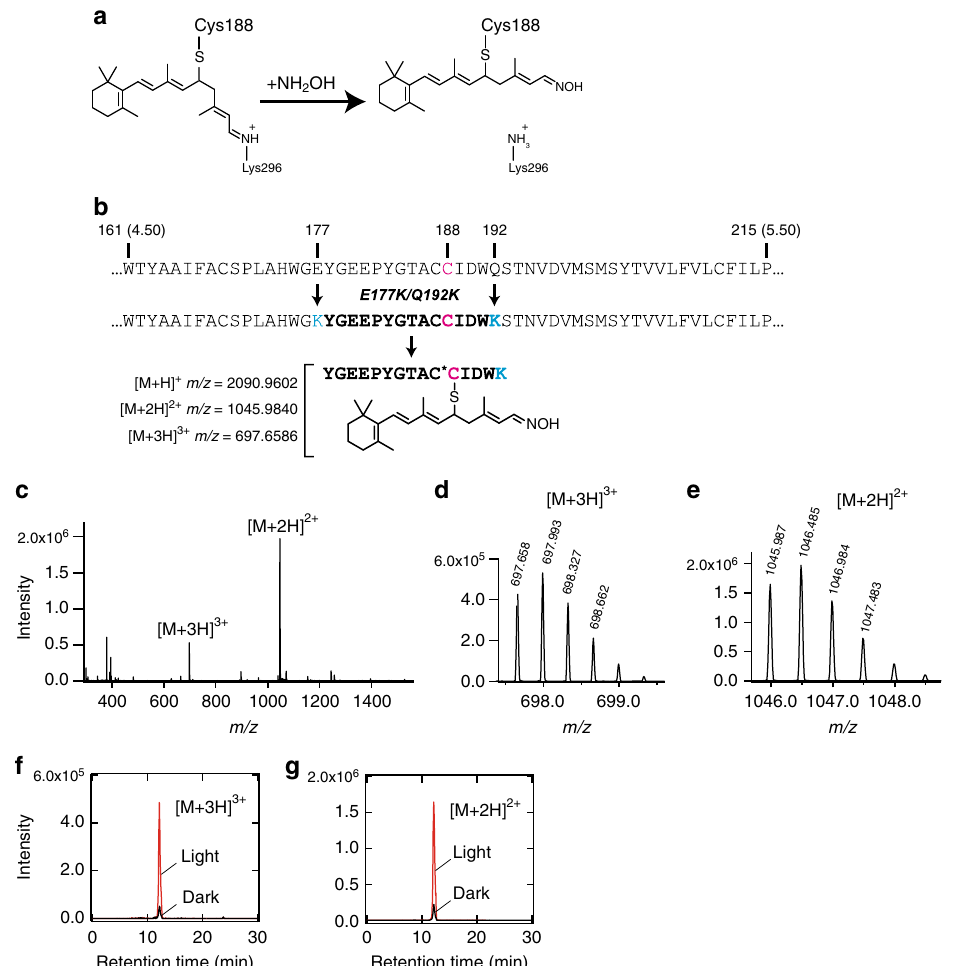
Fig. 4 Detection of retinal-thio adduct formation in light-irradiated Opn5L1 by LC-MS. a Action of hydroxylamine on retinal-thio adduct in Opn5L1. In this fi gure, we show that C 11 is the site of adduction of the retinal chromophore to C188. b Amino acid sequences of fragments containing C188 in Opn5L1NC and Opn5L1NC E177K/Q192K mutant. Structure of the expected peptide (after light irradiation in the presence of hydroxylamine, breakdown of disul fi de bond between C110 and C187, carbamidomethylation of free cysteine, and tryptic digestion) is shown below. Amino acids are numbered based on the bovine rhodopsin numbering system. Numbers shown in parentheses are according to Ballesteros − Weinstein numbering. Asterisk indicates carbamidomethylation. c Mass spectrum recorded at the retention time of 12.15 min, peak time of m/z = 1045.984 ± 0.05 corresponding to isotopic m/z of [M + 2H] 2 + of the peptide YGEEPYGTAC*C(retinaloxime)IDWK. The mass signals of [M + 2H] 2 + and [M + 3H] 3 + ions of YGEEPYGTAC*C (retinaloxime)IDWK are indicated. d , e Enlarged view of the mass signals of [M + 3H] 3 + ( d ) and [M + 2H] 2 + ( e ) from c , respectively. f , g LC-MS pro fi les of m/z = 697.659 ± 0.05 ( f ) and 1045.984 ± 0.05 ( g ) corresponding to isotopic m/z of [M + 3H] 3 + and [M + 2H] 2 + of the peptide YGEEPYGTAC*C (retinaloxime)IDWK, respectively. The traces obtained from the light-irradiated (red) and the dark-adapted (black) samples are (Supplementary Fig. 12a − c). The photosensitivity of Opn5L1 thus obtained was 0.73 relative to that of bovine rhodopsin, which is comparable to the photosensitivities of other opsins such as cone pigments and melanopsin 26,27 . Using this value together